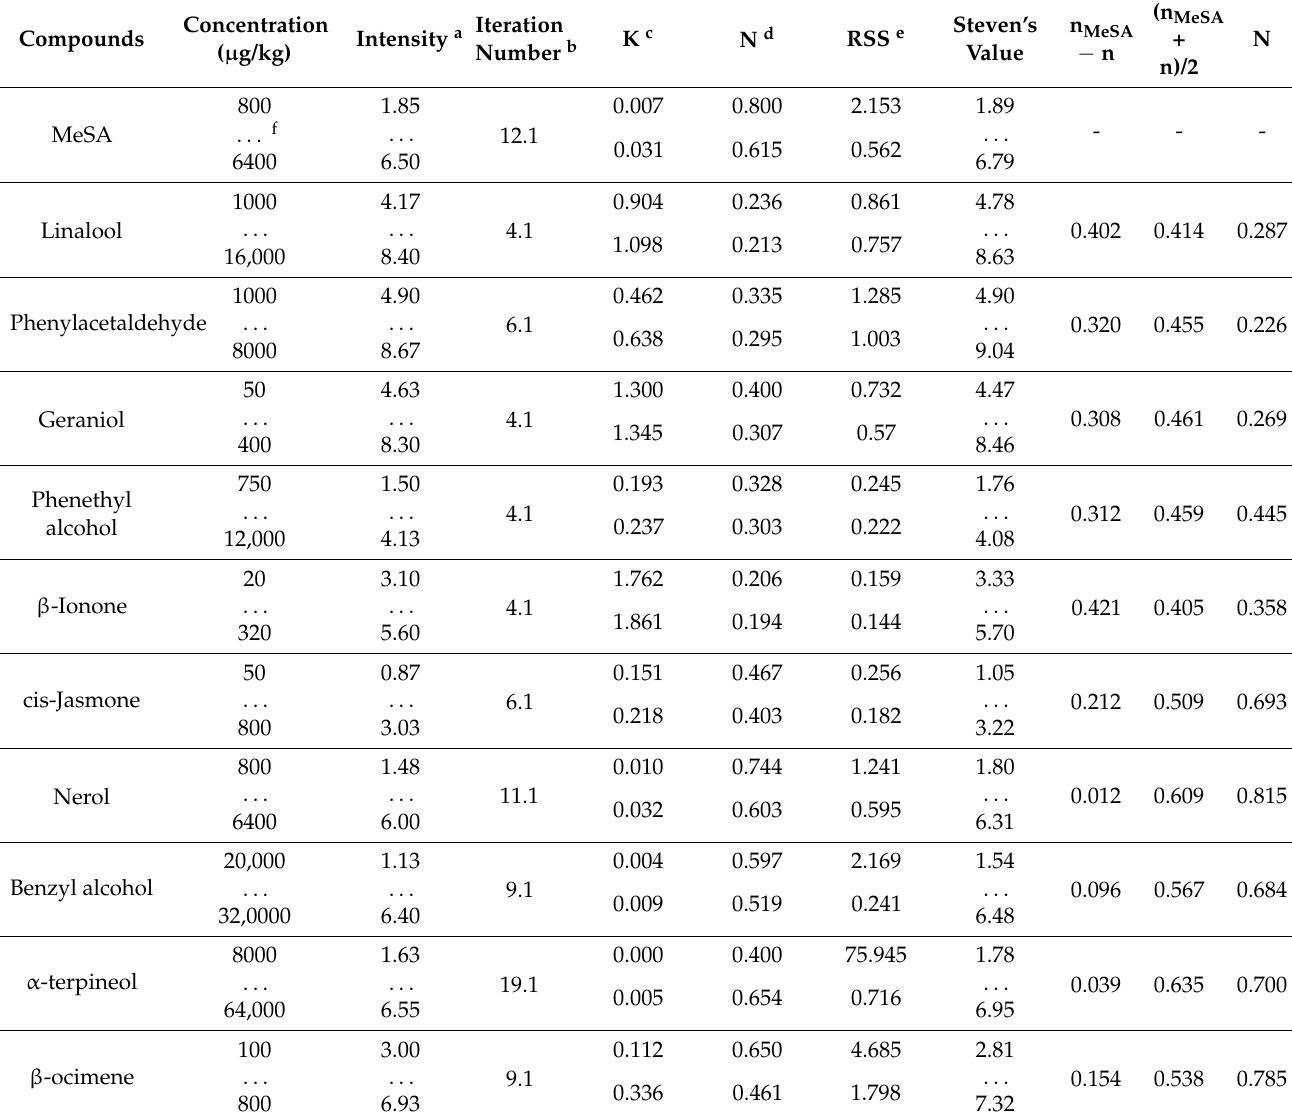
Table 3. The n value of Steven’s law and the n